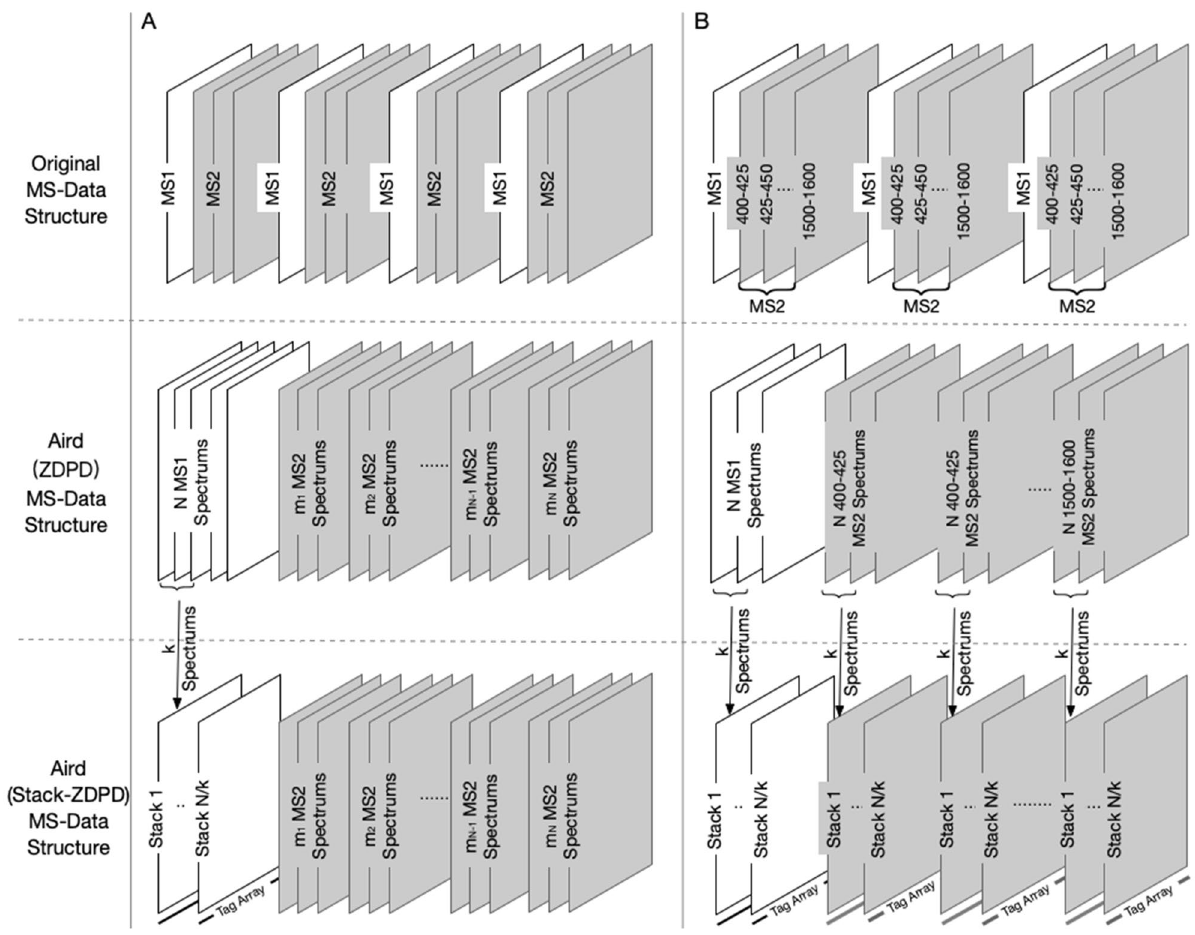
Figure 7. ( A ) MS-Data structures in data acquisition mode of DDA. In DDA mode, each MS1 spectra is originally followed by several relevant MS2 spectra. In data organization of Aird (ZDPD), MS1 spectra are gathered as MS1 block to accelerate the extracted ion chromatogram (XIC) calculation. According to Stack- ZDPD, each k spectra are combined before compression, so the output data is composed of several stacks, the merged spectrums. Each stack is stored along with a Zlib-compressed tag array for decoding. It should be noted that the number of spectra mi in the MS2 block is often not very large, thus MS2 data keeps the structure in Aird (ZDPD). ( B ) MS-Data structures in SWATH/DIA mode. Different from DDA mode, each MS2 spectra in DIA is set to a certain m/z SWATH window and MS2 data in the same window is generally extracted for analysis. Therefore, MS2 data is stored as MS2 blocks according to its m/z SWATH window and spectrum number of each MS2 block is theoretically same as MS1 block. Further, data in each block is stored as stacks to achieve better compression